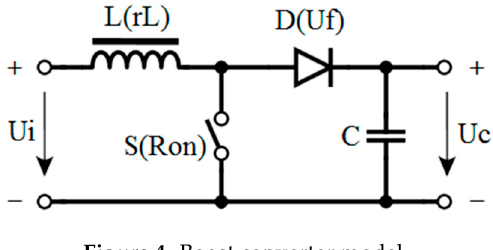
Figure 4. Boost converter model.